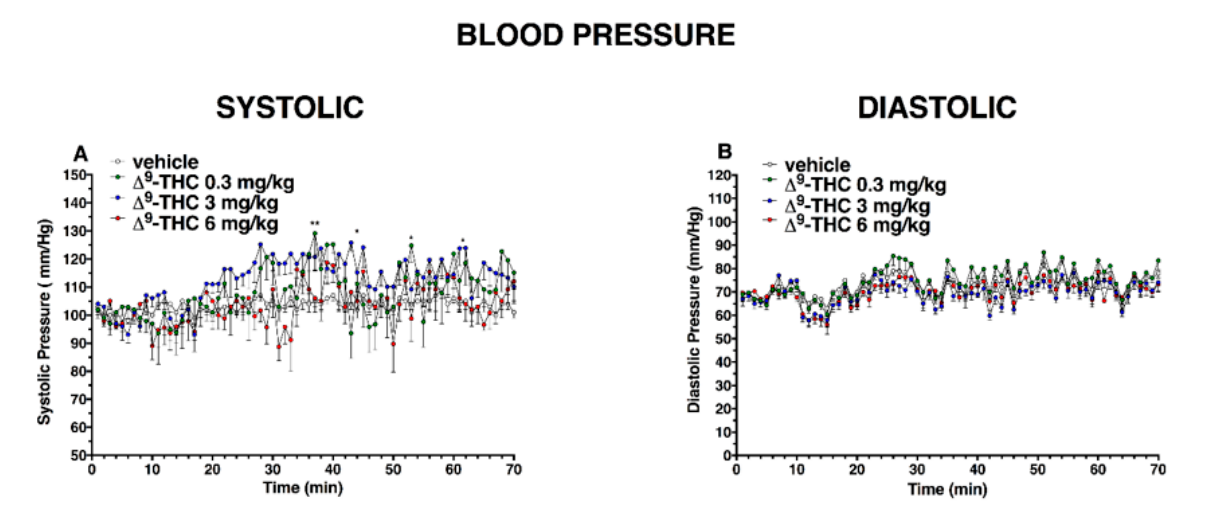
Figure 10. Effect of systemic administration of ∆ 9 -THC (0.3–6 mg/kg on systolic (panel ( A )) and diastolic (panel ( B )) blood pressure. Data are expressed as absolute values (mm/Hg) in the form MEAN ± SEM of 8 different evaluations for each group. Statistical analysis was performed by two-way ANOVA, followed by Bonferroni’s test for multiple comparisons. * p < 0.05 ** p < 0.01 versus